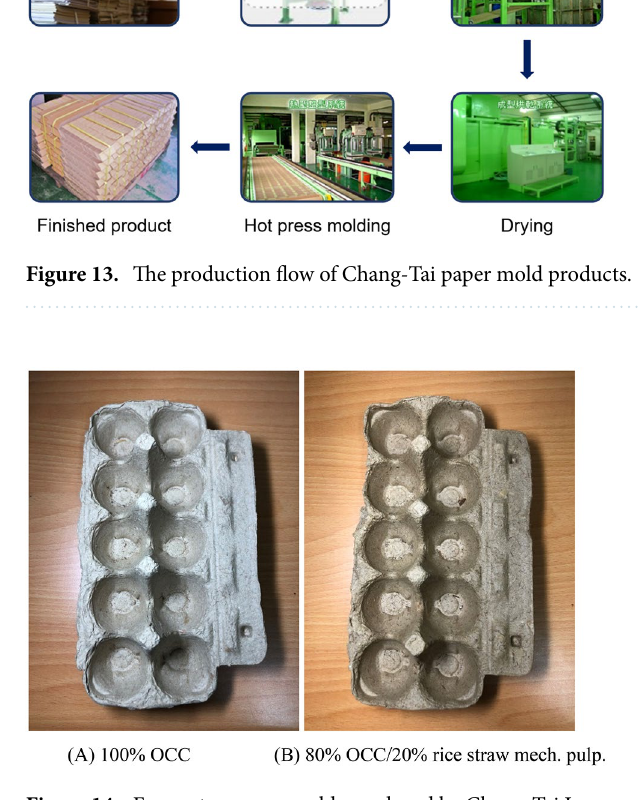
Figure 14. Egg carton paper molds produced by Chang-Tai